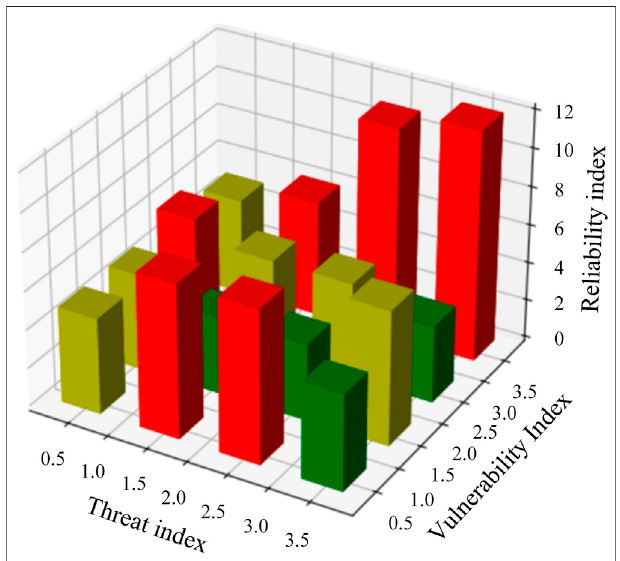
FIGURE 3 | Spatial element index simulation under the attack